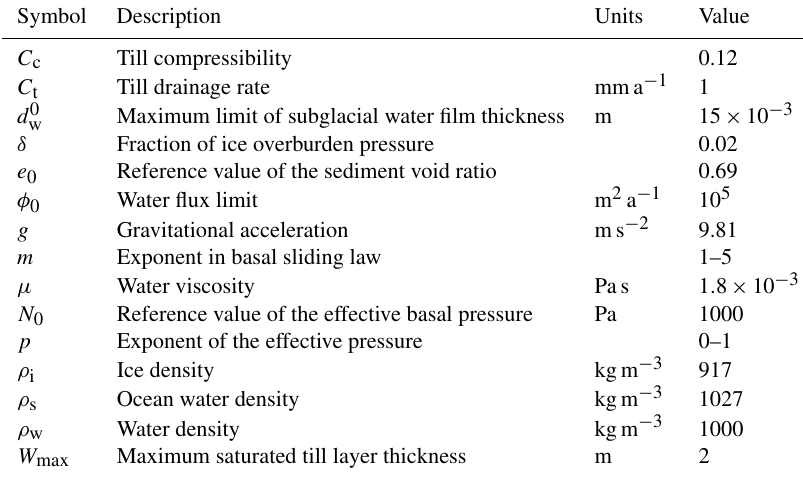
Table 1. List of constants and parameters used. Symbol Description Units Value C c Till compressibility 0.12 C t Till drainage rate mma − 1 1 d 0 w Maximum limit of subglacial water film thickness m 15 × 10 − 3 δ Fraction of ice overburden pressure 0.02 e 0 Reference value of the sediment void ratio 0.69 φ 0 Water flux limit m 2 a − 1 10 5 g Gravitational acceleration ms − 2 9.81 m Exponent in basal sliding law 1–5 µ Water viscosity Pas N 0 Reference value of the effective basal pressure Pa p Exponent of the effective pressure 0–1 ρ i Ice density ρ s Ocean water